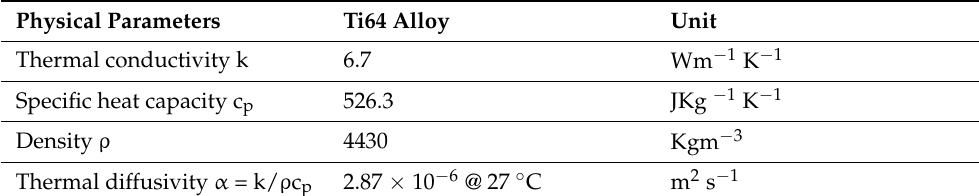
Table 2. Physical parameters of Ti64